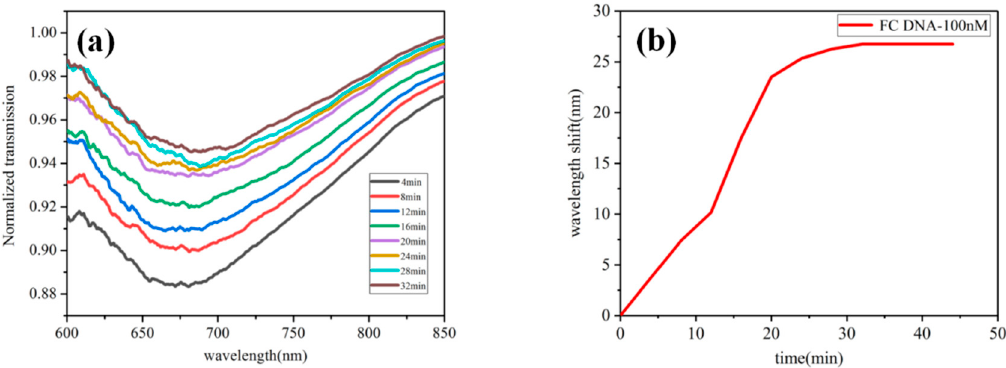
Figure 9. ( a ) The normalized projection spectra for real-time monitoring of FC DNA at 100 nM concentrations. ( b ) The function of wavelength shift over time.